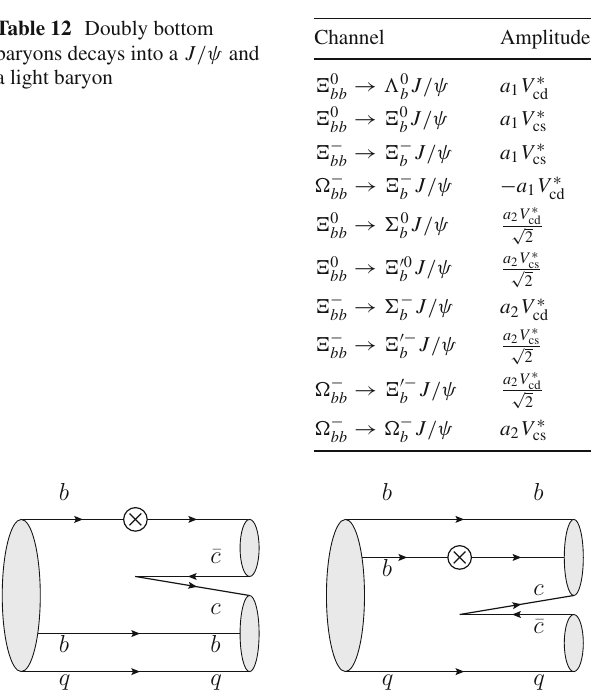
Table 12 Doubly bottom